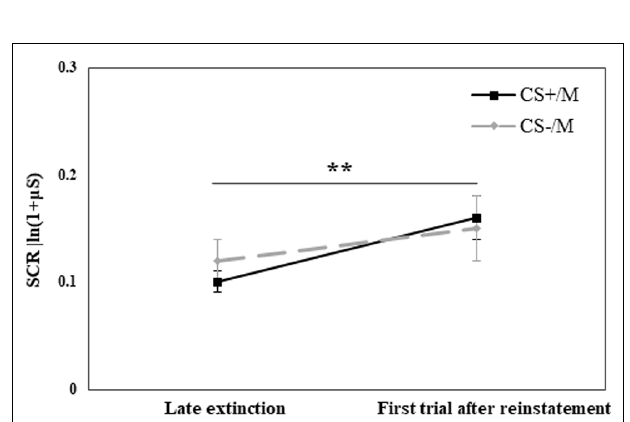
FIGURE 5 | Day 3: Analyses of the reinstatement test to the modified stimuli compared the mean ( ± SEM) SCR to the stimuli in the late phase of extinction (mean of last 5 trials of the original CS+ or CS − ; late extinction original CS+: RE+CORT: 0.08 ± 0.02; RE: 0.13 ± 0.03; CORT: 0.09 ± 0.02; late extinction original CS − : RE+CORT: 0.09 ± 0.03; RE: 0.14 ± 0.03; CORT: 0.12 ± 0.03) and the first trial after reinstatement (modified stimulus, CS+M or CS − M; first reinstatement trial CS+M: RE+CORT: 0.11 ± 0.03; RE: 0.18 ± 0.04; CORT: 0.18 ± 0.04; first reinstatement trial CS − M: RE+CORT: 0.16 ± 0.05; RE: 0.12 ± 0.04; CORT: 0.18 ± 0.05). The analysis revealed a generalized reinstatement (i.e., to both CS+M and CS − M; ∗∗ p = 0.005). Since no group effect or interaction were found, the figure presents all three experimental groups combined ( N = 73; RE+CORT group: n = 24, RE group: n = 25, CORT group: n =